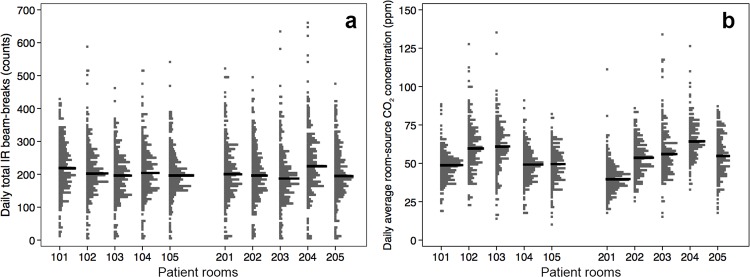
Surrogates for daily human occupancy and activity: (a) daily total IR bream-break counts and (b) daily average room-source CO2 concentrations.Rooms 101–105 are on the 9th floor; rooms 201–205 are on the 10th floor. The horizontal black bar represents the median daily values